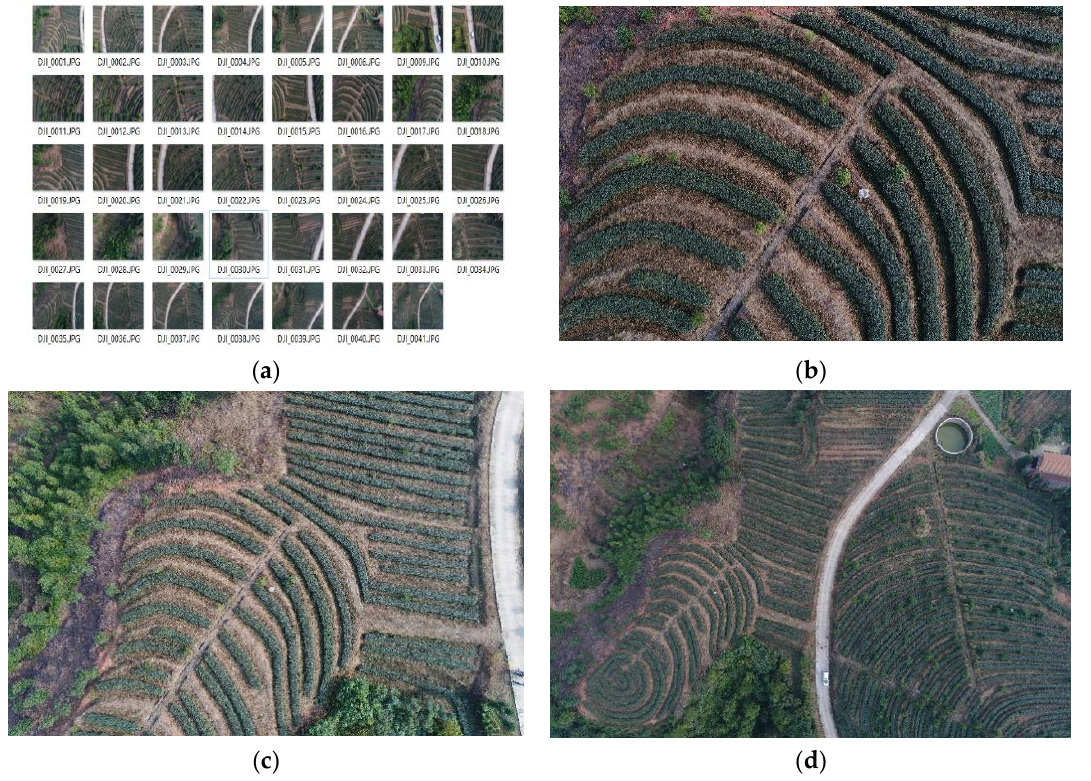
Figure 2. Raw image datasets of the tea garden. ( a ) Images of the tea garden dataset; ( b ) one image from 30 m high (“Group 1”); ( c ) one image from 60 m high (“Group 2”); ( d ) the image from 100 m high (“Group 3”).